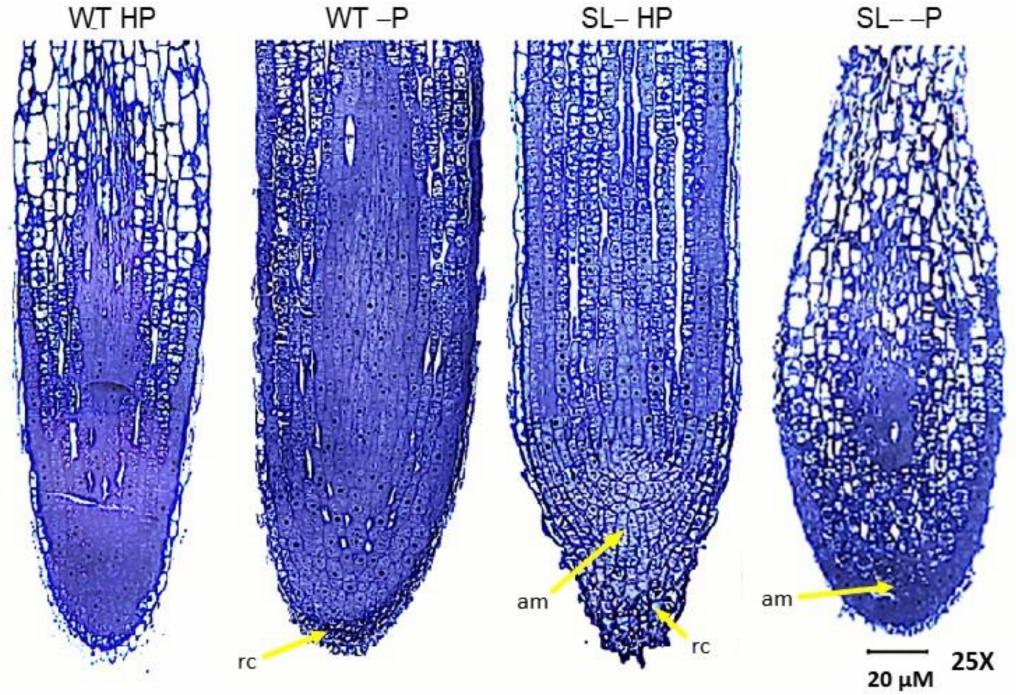
Figure 6. Light micrographs of longitudinally sectioned root tips of wild-type (WT) and strigolactone- depleted plants (SL–) grown for 10 days in MS medium with either high P or low P and further transferred for one week to MS medium containing either high P (HP) or no P (–P), respectively. In WT HP plants, the postmitotic isodiametric growth zone is reduced in length compared to WT –P plants, and the cells acquire an elongated shape closer to the apical meristem (am). In WT –P plants, an extended postmitotic isodiametric growth, with cells maintaining their isodiametric shape, is visible throughout the root tip. Note the wider root tip diameter compared to WT HP plants. In SL– HP plants, note the root cap (rc) with cells enclosing several small vacuoles, the cone shape of the root apex, and the maintenance of cells with meristematic features along the root longitudinal axis. Above the apical meristem are many cells with isodiametric shape and several vacuoles scattered in the cytoplasm. The root tip of SL– –P plants is swollen and displays high levels of disorganization. A small apical meristem is visible in the center. Above it, most cells are elongated, with a large central vacuole. Below it, cells are isodiametric with several small